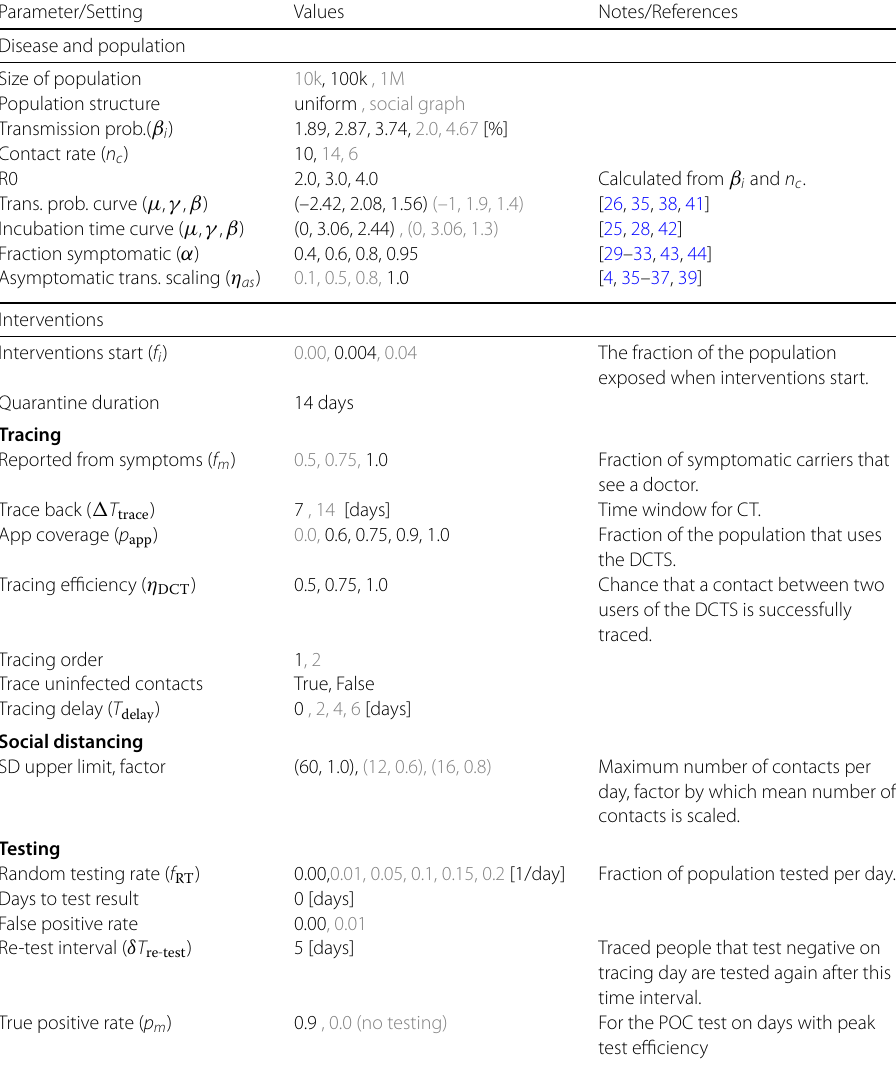
Table 1 Key model input parameters and settings. The models are evaluated for all possible combinations of all parameter values shown in black. Parameter values in grey are used only